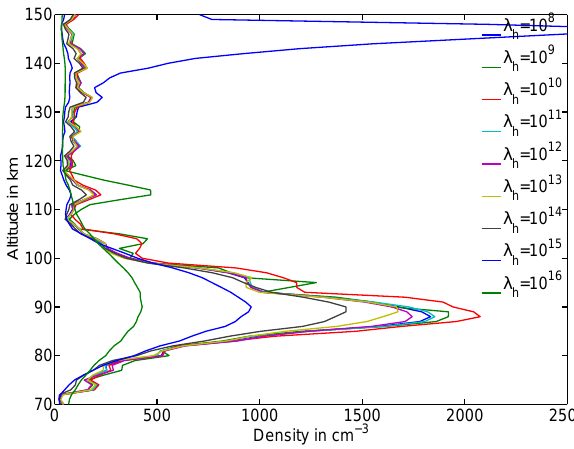
Fig. 28. Retrieval results with a 1-D model for the error free 4yr av- eraged equatorial profile for Mg (comparable with the red line solu- tion in the plots in Sect. 4.1). Different vertical constraints are cho- sen and λ h = 10 × λ apriori . With increasing constraint strength there is a sharp transition from a totally oscillating solution to a smooth solution. This result is stable within 12 orders of magnitude in the constraints strength until the result is smoothed too strongly. Note that the numerical value of the constraints is slightly different here than for the 2-D model.